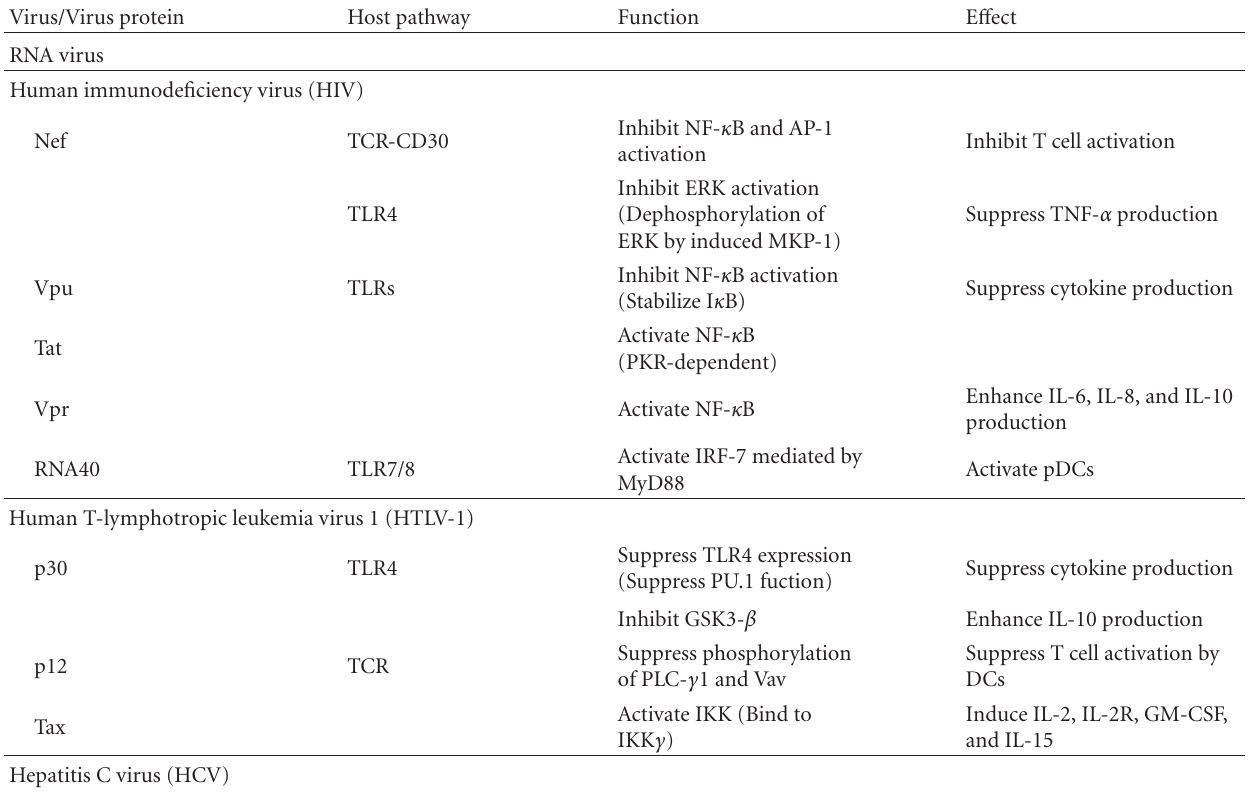
Table 1: Molecular mechanisms involved in modulation of host innate immune systems by